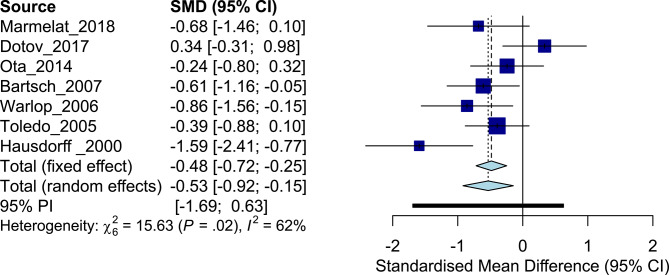
Forest plot: patients with Parkinson disease vs. age-matched asymptomatic controls.